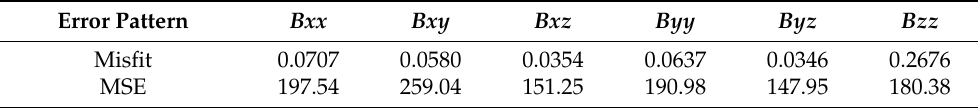
Table 6. Rectangle model‘s prediction Misfit and MSE.